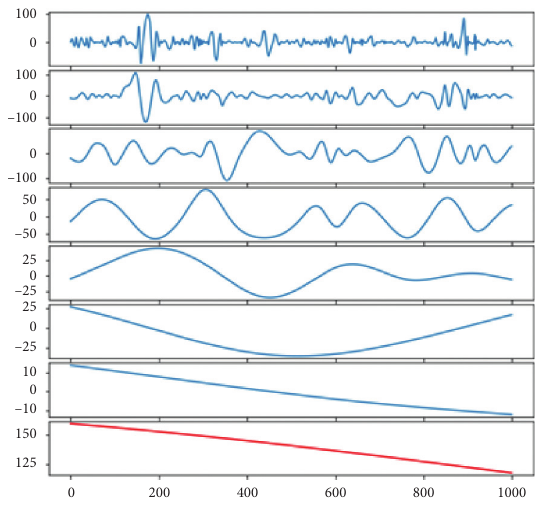
Figure 7: The decomposition result diagram of EMD.